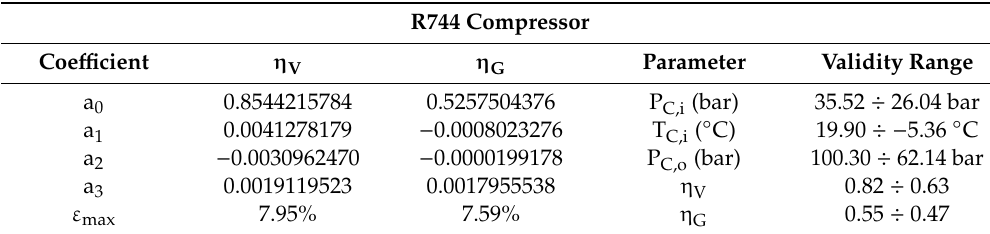
Table 5. Experimental coe ffi cients for the CO 2 hermetic